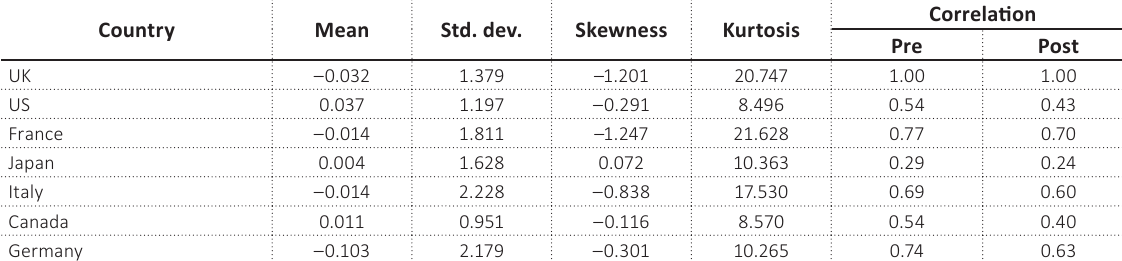
Table 1. Descriptive statistics for returns on bank equity indices